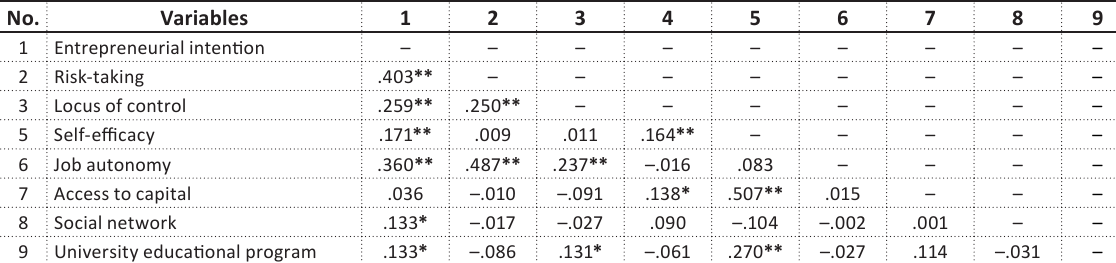
Table 2. Correlation between entrepreneurial intention and predictive variables No.